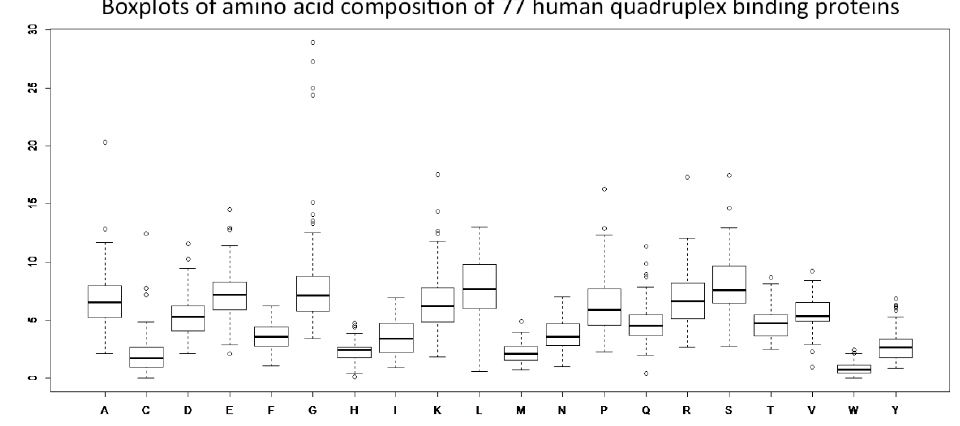
Figure 1. Boxplots of amino acid compositions of 77 quadruplex binding proteins. Thick horizontal lines within boxplots denote mean amino acid composition values. Data within boxes span the interquartile range and whiskers show the lowest and highest values within 1.5 interquartile range. Empty circles denote outliers.